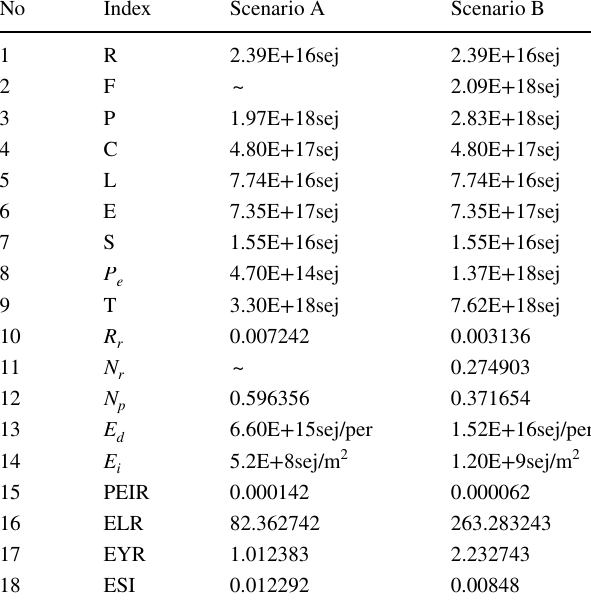
Table 7 Calculated results of ecological indicators